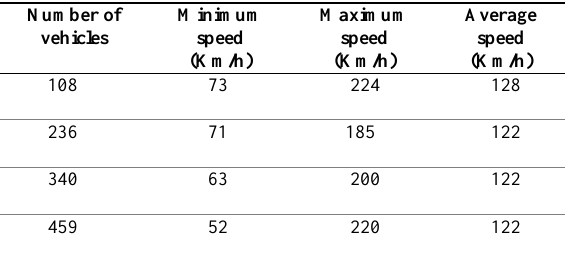
Table 4. Detailed specifications of the vehicles in three different